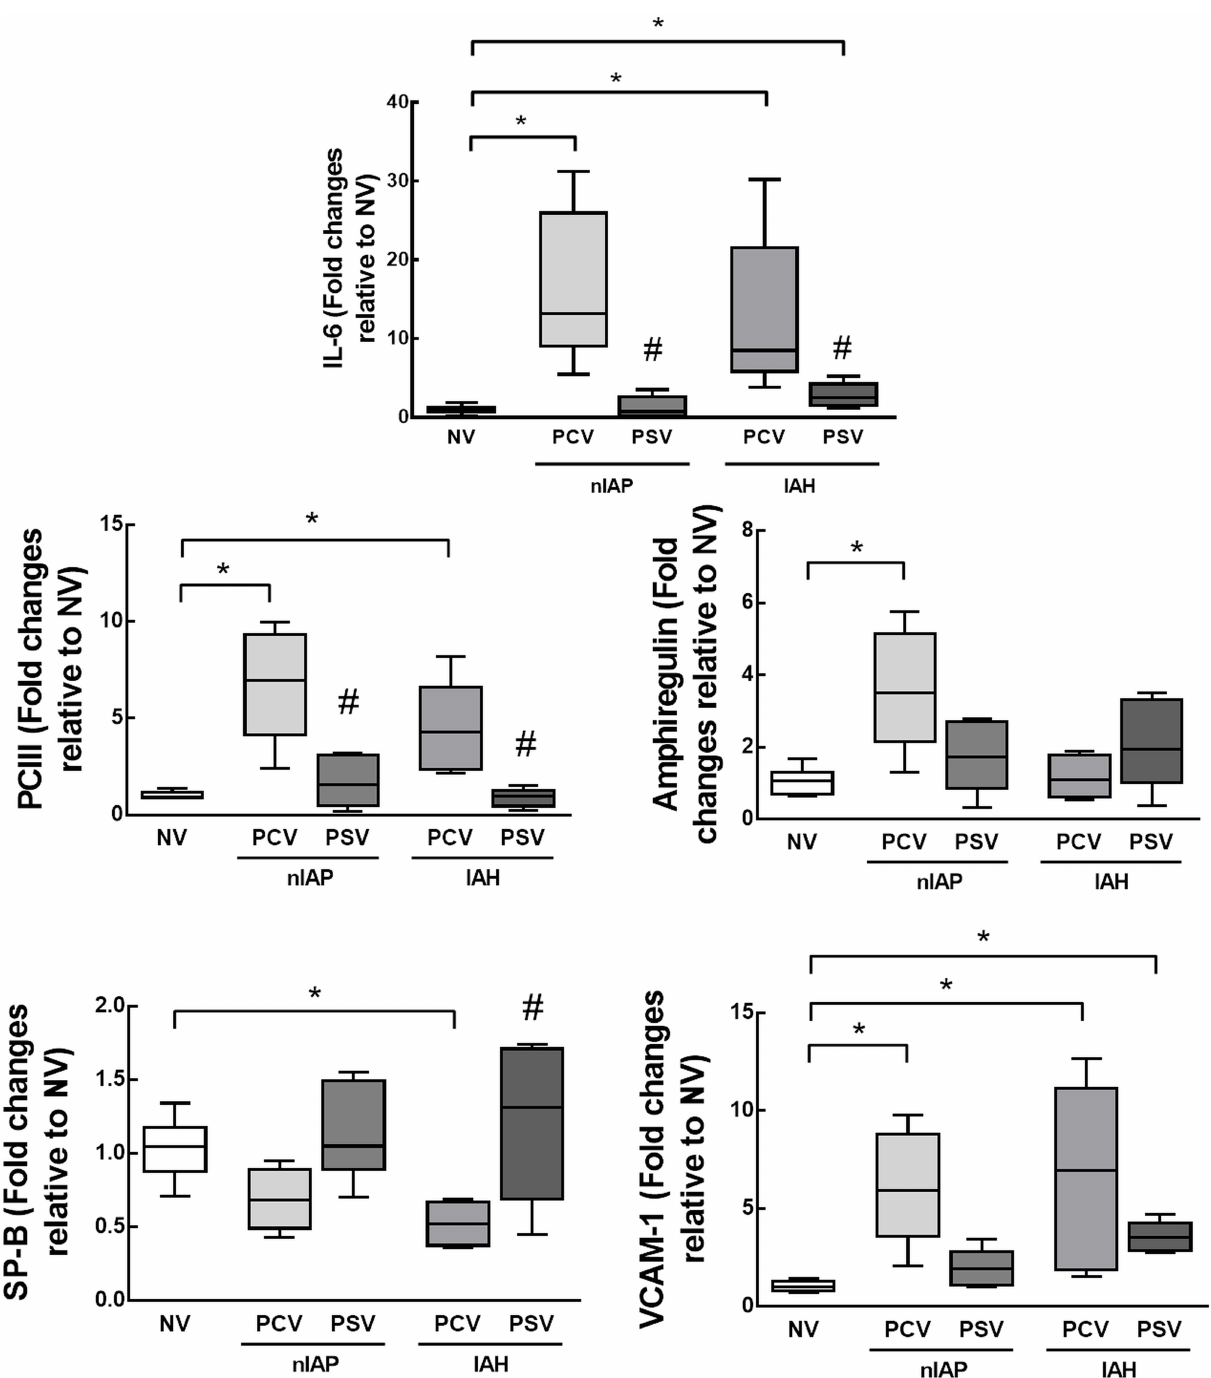
Fig 3. Real-time polymerasechain reaction analysis of biological markers associated with inflammation (interleukin [IL]-6), fibrogenesis (type III procollagen [PCIII]), pulmonary stretch (amphiregulin), type II epithelial cell damage (surfactant protein [SP]- B), and endothelial cell damage (vascular cellular adhesion molecule [VCAM-1]) in animals with normal intra-abdominal pressure (nIAP) or intra-abdominal hypertension (IAH) mechanically ventilated in pressure-controlled ventilation (PCV) or pressuresupport ventilation (PSV) mode. Values are given as medians,interquartile ranges, and minimum/maximum of 6 animalsin each group. Relative gene expressionwas calculatedas a ratio of averagegene expressioncomparedwith the reference gene ( 36B4 )and expressedas fold changerelative to non-ventilated (NV) animals. * Significantlydifferent from NV (p < 0.05).#Significantlydifferent from PCV (p < 0.05).